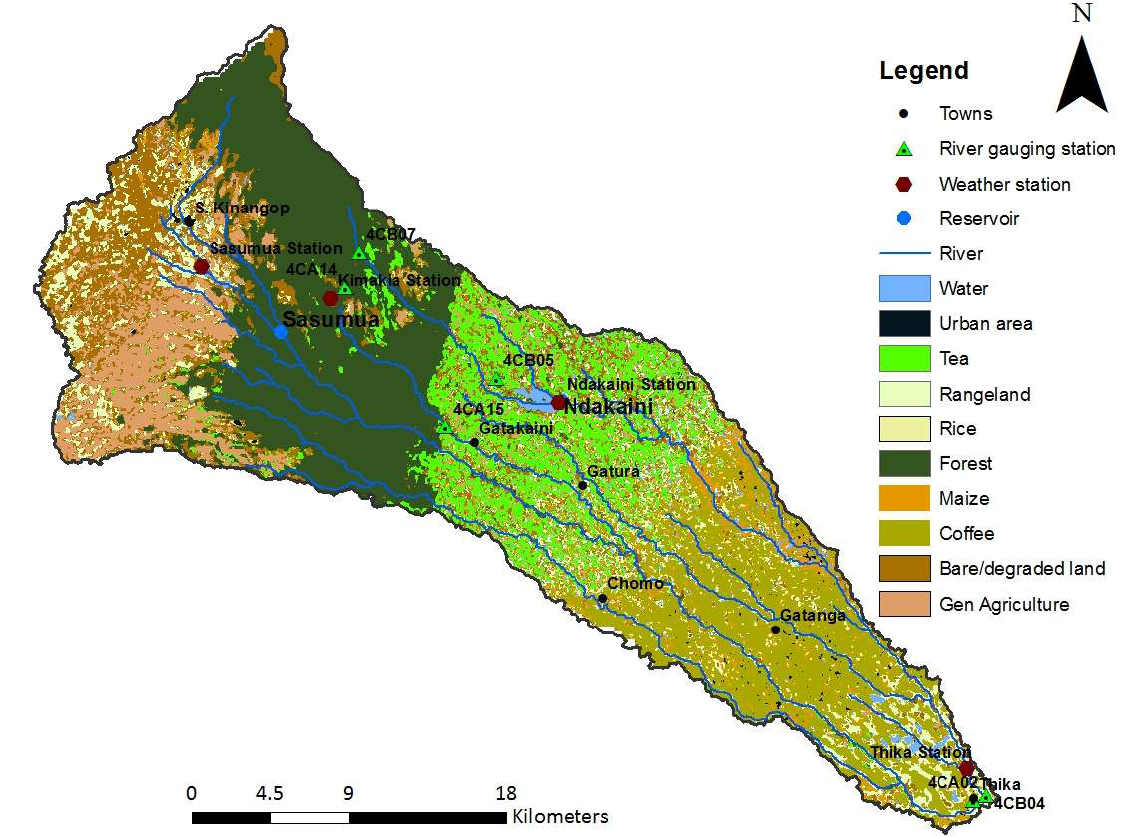
Figure 2. Land use at Thika-Chania catchment.